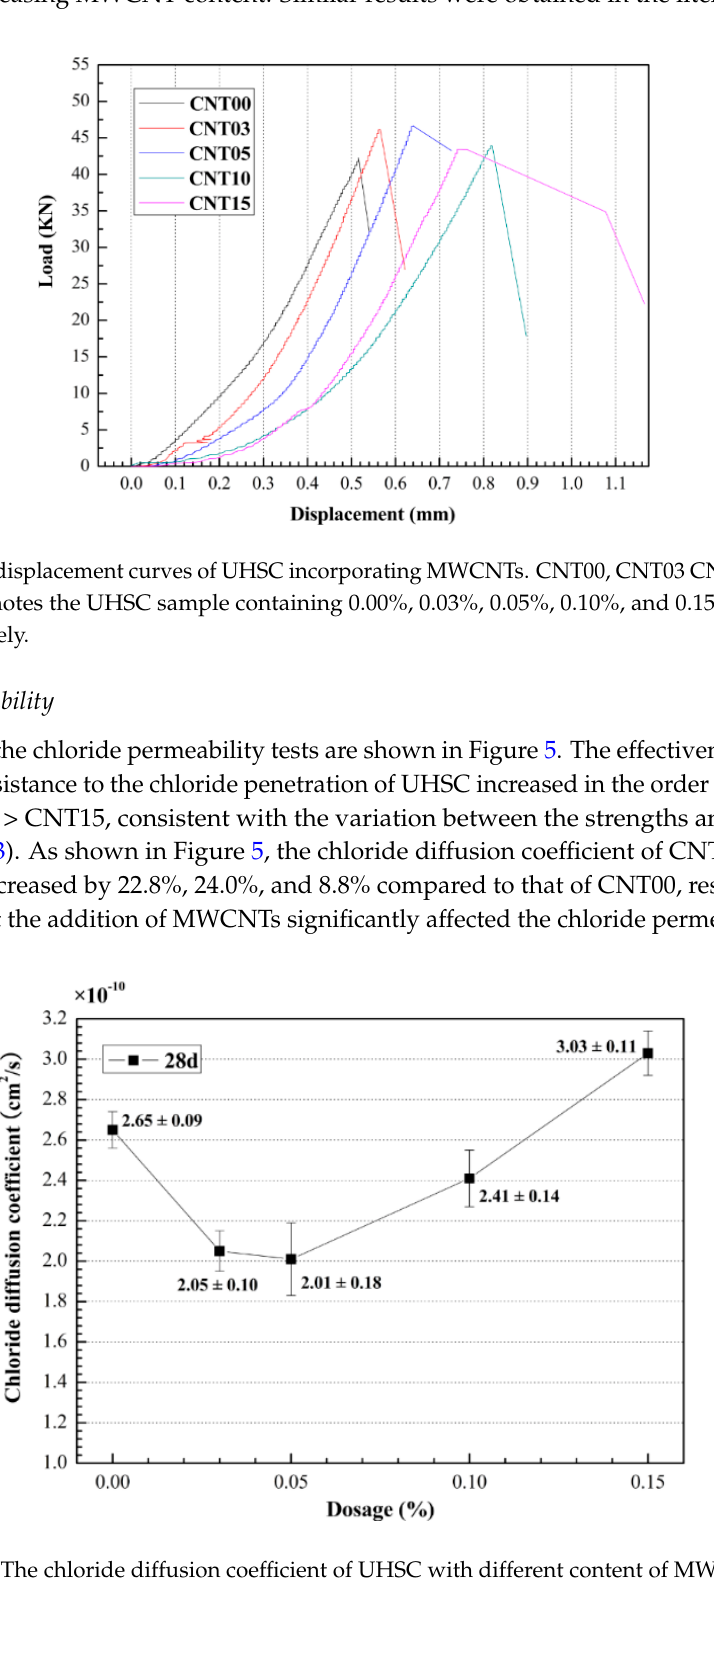
Figure 3. Mechanical properties of UHSC containing MWCNTs. ( a ) compressive strength; ( b ) flexural strength.